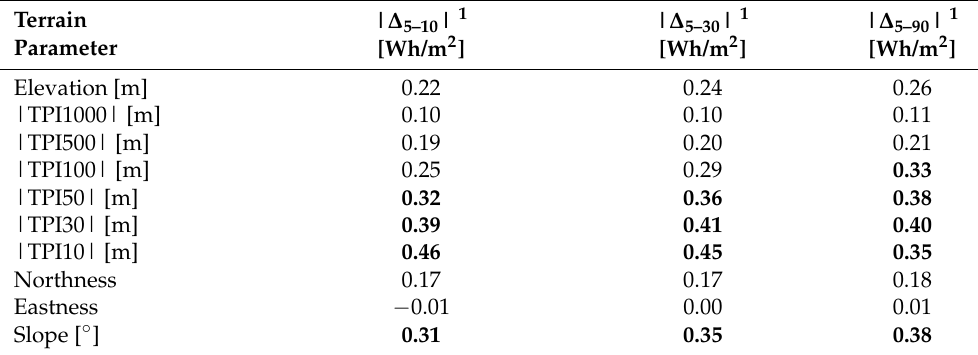
Table 4. Mutual correlations of solar radiation differences calculated based on DEM at different resolutions (5 m vs. 10 m, 30 m, and 90 m) and the terrain parameters (elevation, |TPI1000|, |TPI500|,